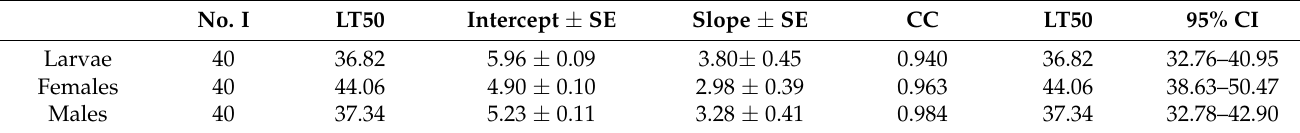
Table 2. The toxicity probit analysis of median lethal time of Bacillus thuringiensis against later instar larvae, females, and males of Rhynchophorus ferrugineus. NoI: number of insects; LT50: Median Lethal Time (hours); CC: Correlation Coefficient; CI: confidence interval